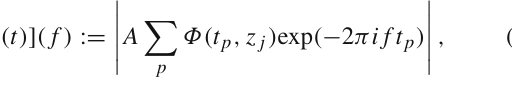
Table 2 The first resonant mass spectrum ¯ m 2 and half-life t 1 / 2 for different values of the parameter ¯